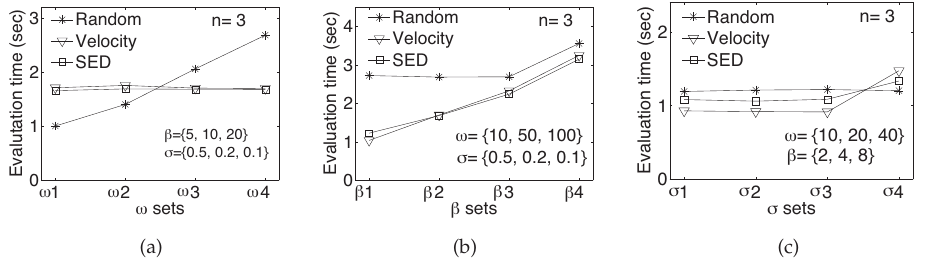
Figure 10: Nested window maintenance cost under diverse